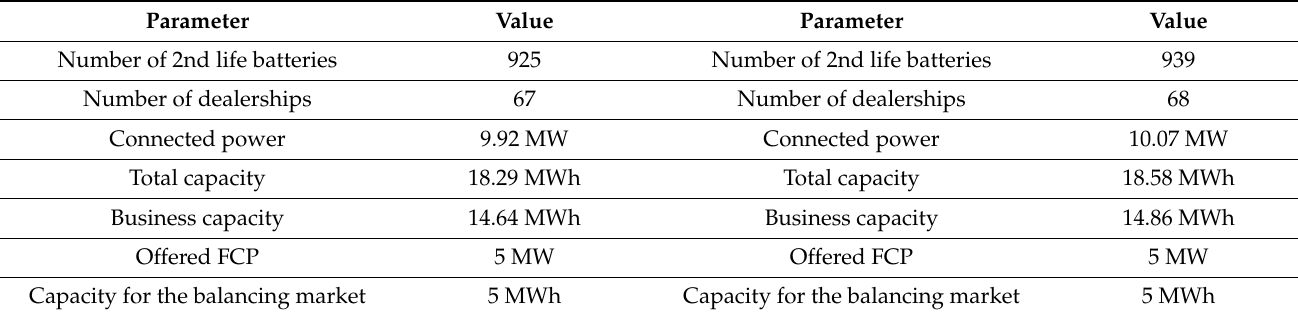
Table 17. Output parameters of the small battery storage strategy after 5 (left) and 10 (right) years.